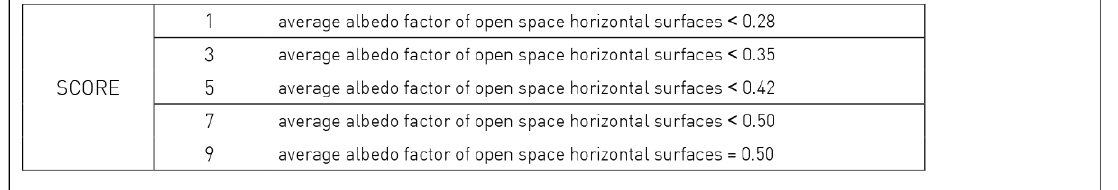
Figure A12. Descriptive sheet of the indicator of “Average albedo of paving surfaces”.